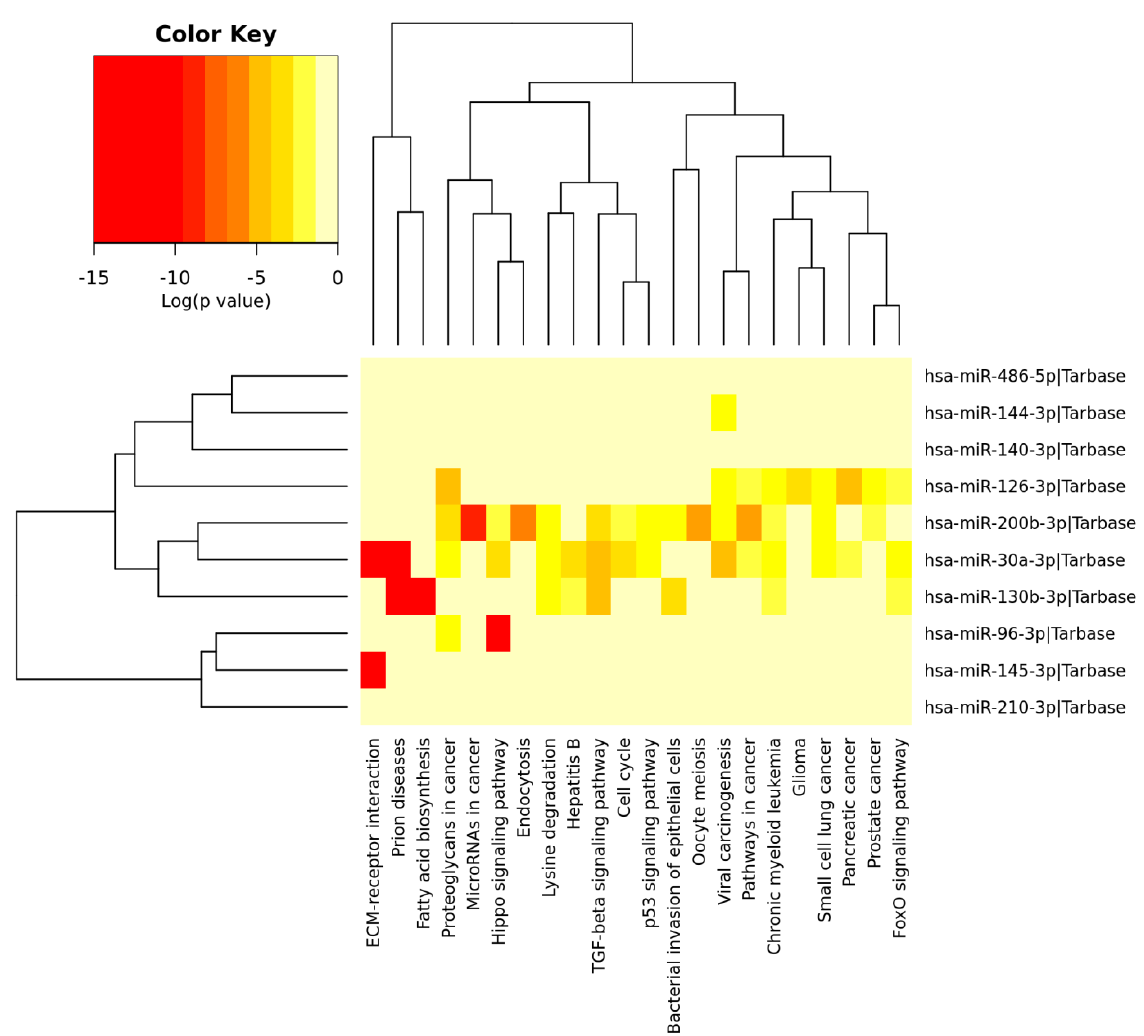
Figure 6. Gene Ontology of the 10 candidate sepsis DEM biomarkers. Representation of functional enrichment of miRNAs showing ( A ) miRNAs versus Molecular Functions, ( B ) miRNAs versus Biological Processes, and ( C ) miRNAs versus Cellular components. Abbreviations: DEMs: Differentially expressed miRNAs. Additionally, Figure 7 illustrates the enriched pathways of top 10 DEMs (4 upregulated and 6 downregulated miRNAs) associated with NSCLC in the form of generated heat map. The significant signal pathways of DEMs were mainly enriched with Hepatitis B, cell cycle, FoxO signaling pathway and Hippo signaling pathway.